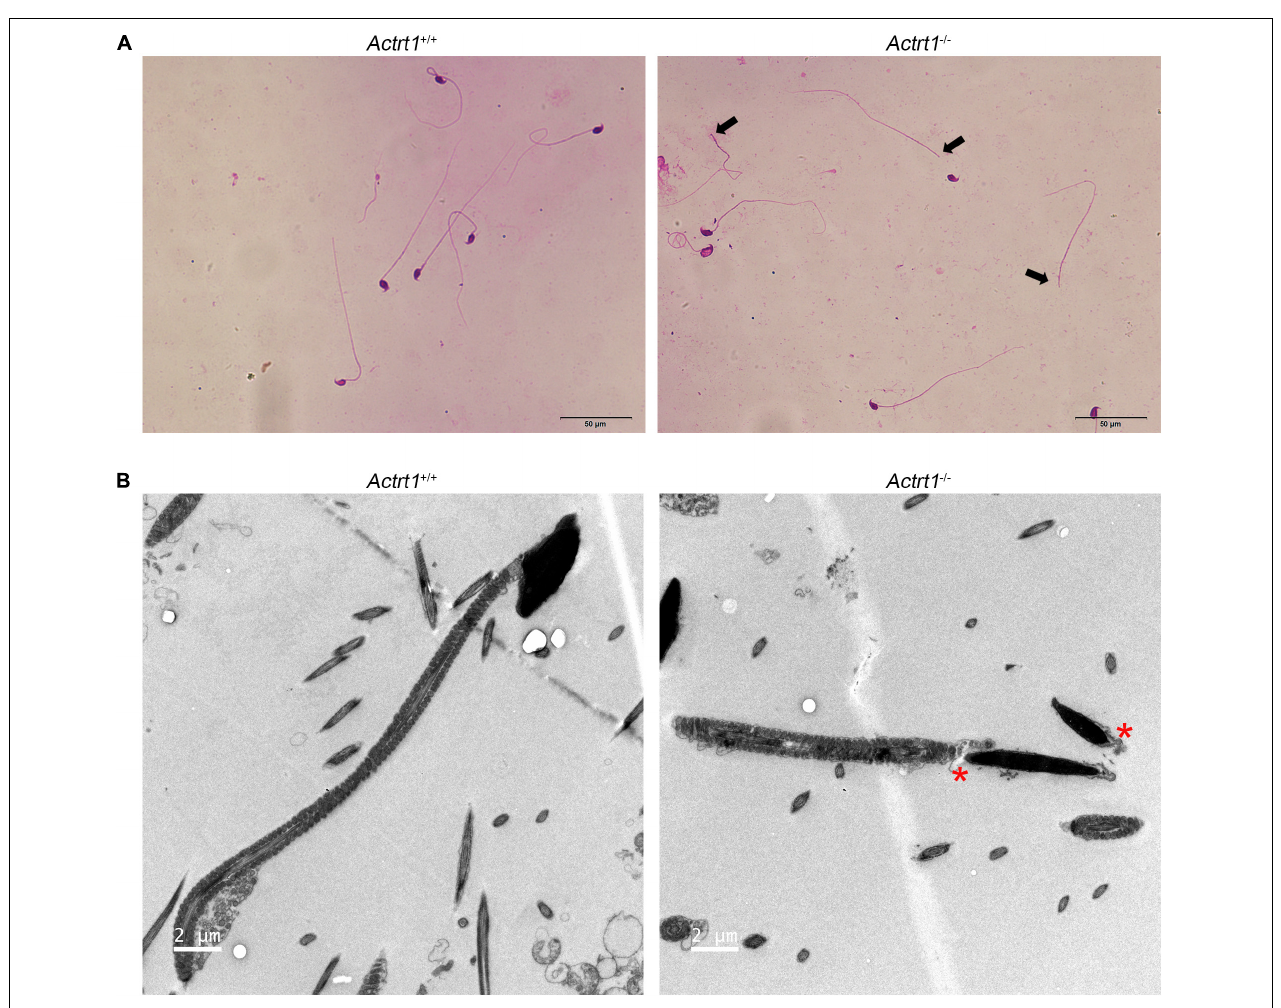
FIGURE 4 | Actrt1 -knockout mice showed a parallel acephalic spermatozoa phenotype. (A) Morphological analysis of spermatozoa from Actrt1 -knockout mice. Spermatozoa from Actrt1 -knockout mice were partially headless. Scale bar: 50 µ m. (B) Ultrastructure of the sperm from Actrt1 + / + and Actrt1 - / - mice. Scale bar: 2 µ